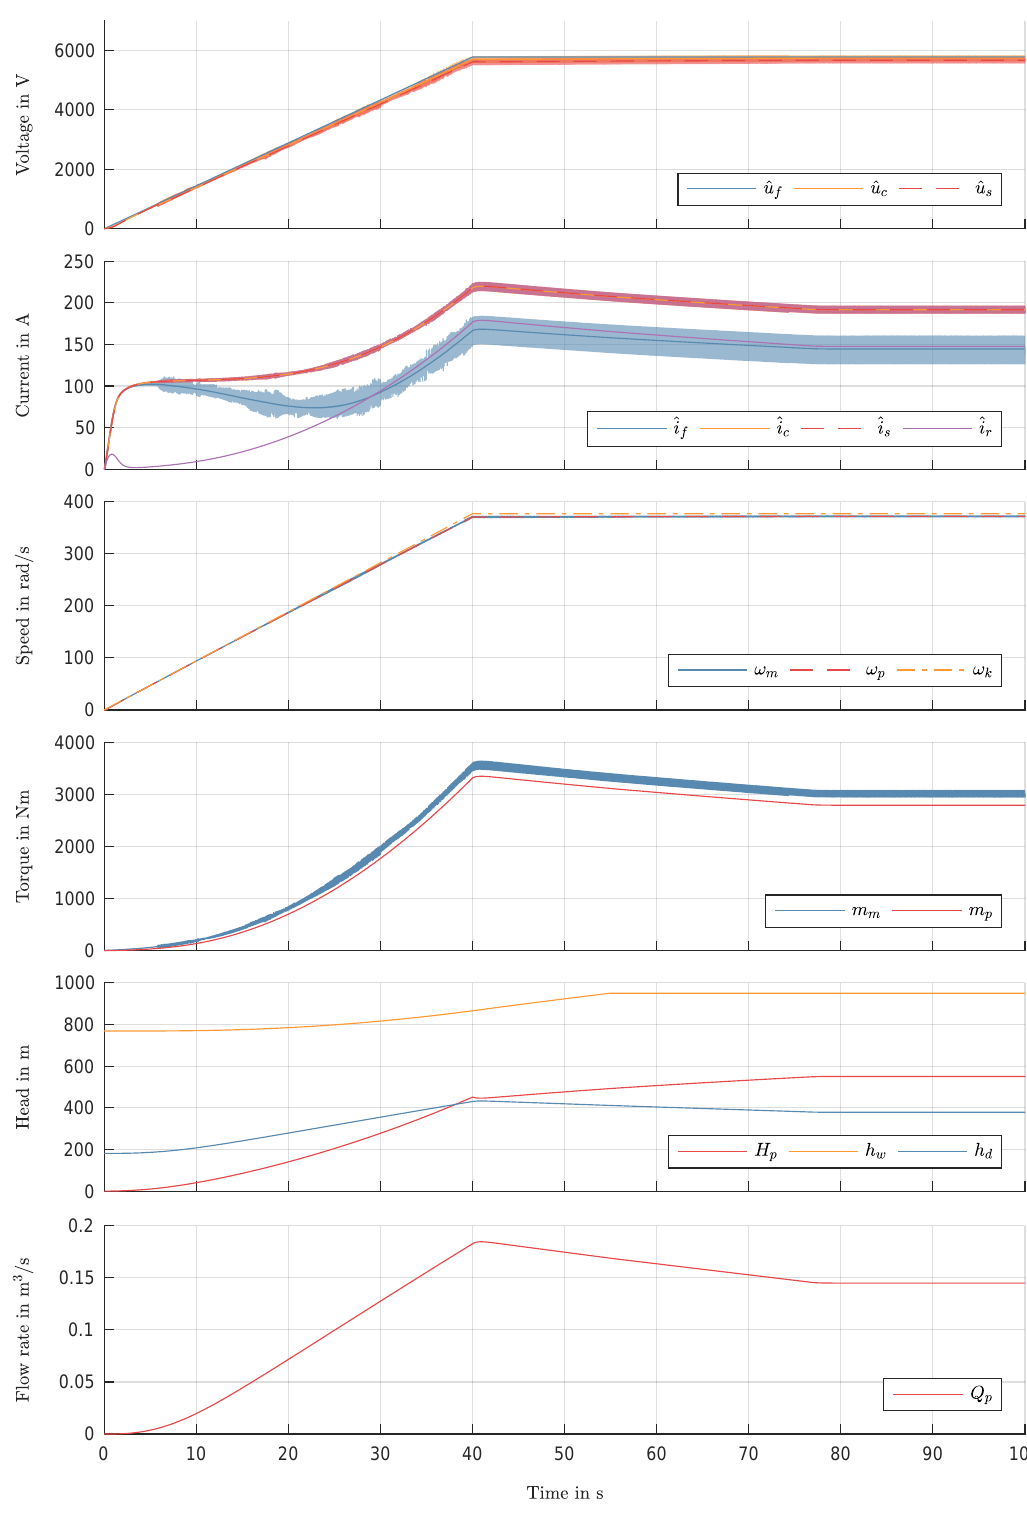
Figure 13. Simulation results (I): Overview of the results from all